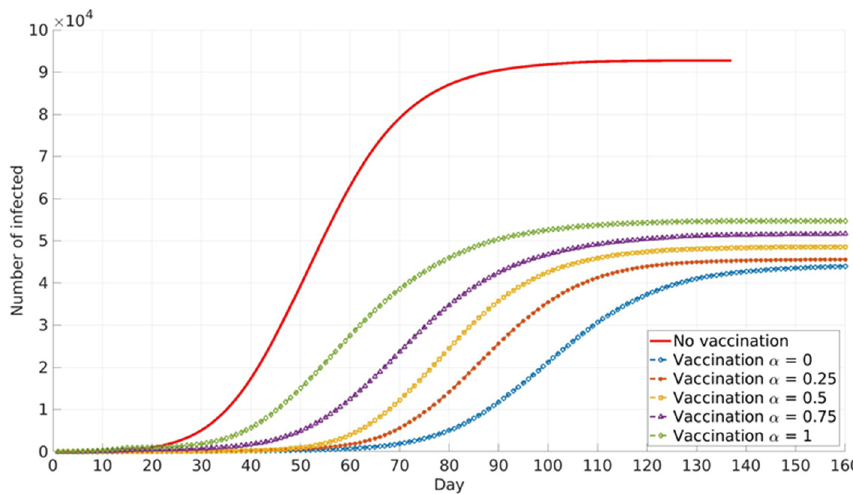
Figure 8. Vaccinated general adult population. The model predicted cumulative numbers of infected cases depending on social parameter α .